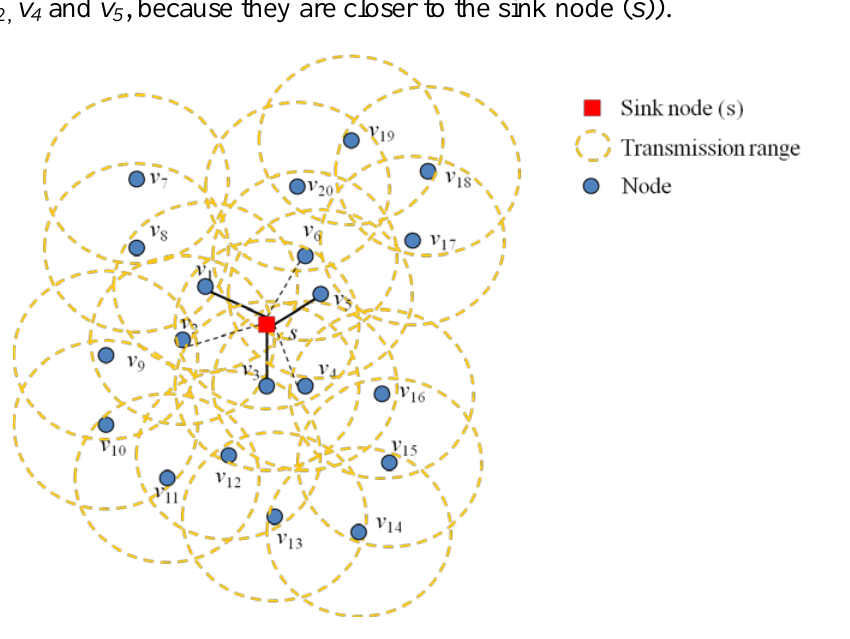
Figure 2. Node set ( Ns ) in the FMSTC algorithm ( v